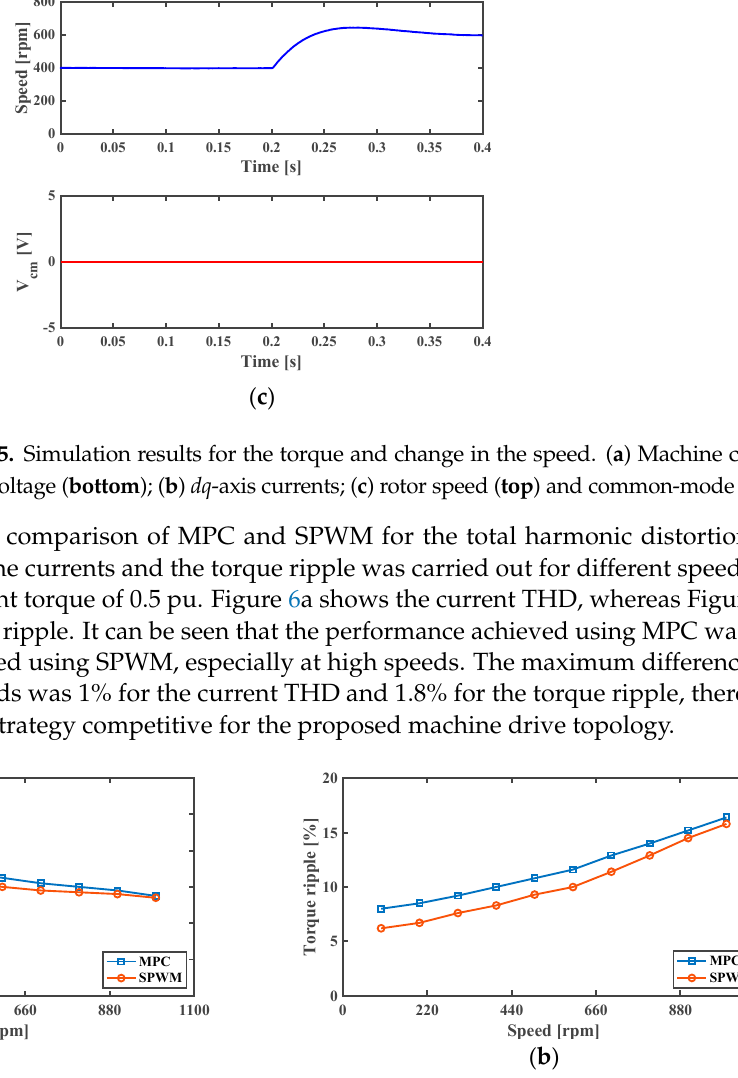
Figure 6. Comparison of MPC and SPWM. ( a ) Current THD as a function of the speed. ( b ) Torque ripple as a function of the speed.